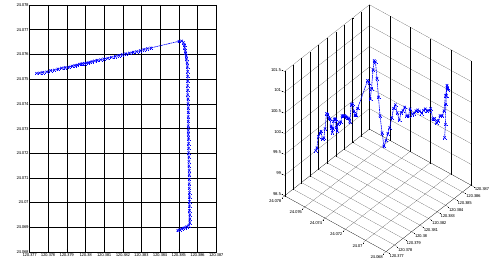
Figure 15 Trajectories of UAV helicopter